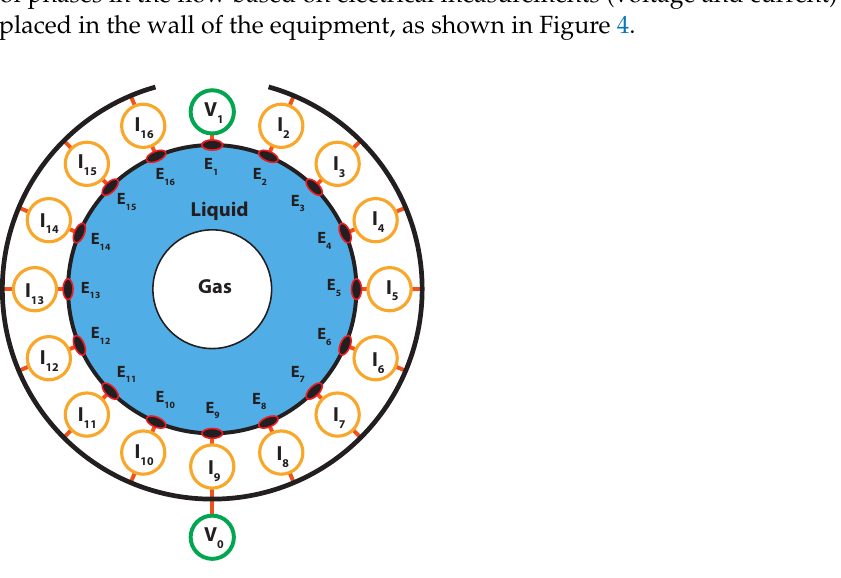
Figure 4. Electrical resistance tomography with 16 electrodes ( E 1 to E 16 ) installed in the inline swirl separator. In this image, electrode 1 is used as the source ( V 1 ), and the remaining electrodes act as the sink. The sink electrodes are kept grounded at V 0 and have their electric currents measured ( I ). Image adapted from [40].